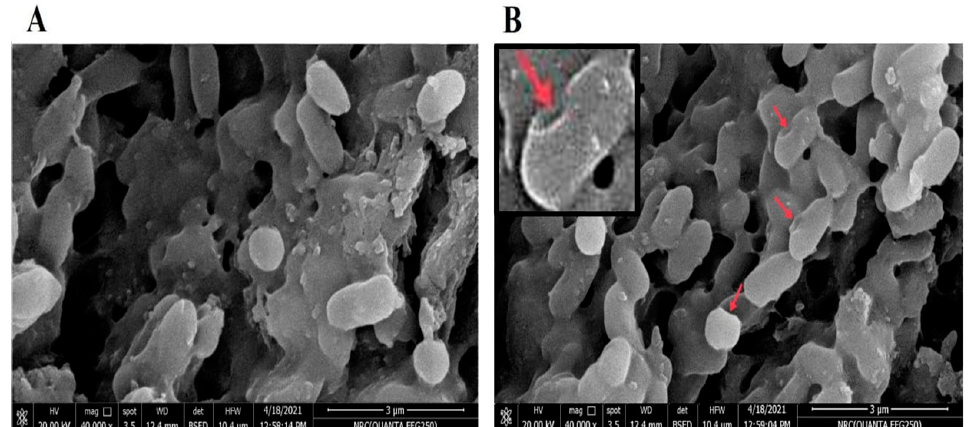
Figure 1. Scanning electron microscopy of treated and untreated N. meningitidis bacterial cells. A photo of scanning electron microscopy of NmC-BG cells ( B ) revealing the trans-membrane lysis tunnels in NmC-BG (small red arrows) compared to untreated bacteria ( A ).